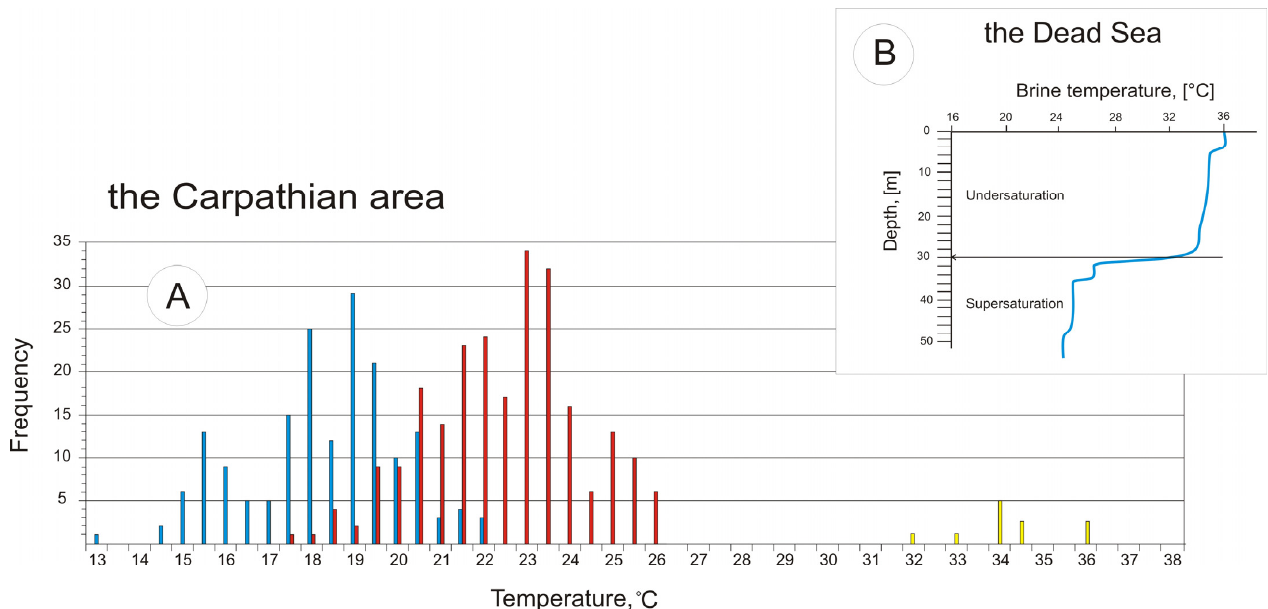
Figure 4. Distribution of the homogenization temperatures of the bottom halite inclusions from Wieliczka Salt Mine, Zbudza, Borehole Ep-2, Hrynivka, Borehole No. 525, and Solotvyno Salt Mine. Colour coding. Blue: temperatures ranging from 13.0 to 22.0 °C in 18 samples. Red: temperatures are ranging from 17.5 to 26.0 °C in 18 samples. The precision of the Th measurement (±0.5 °C).